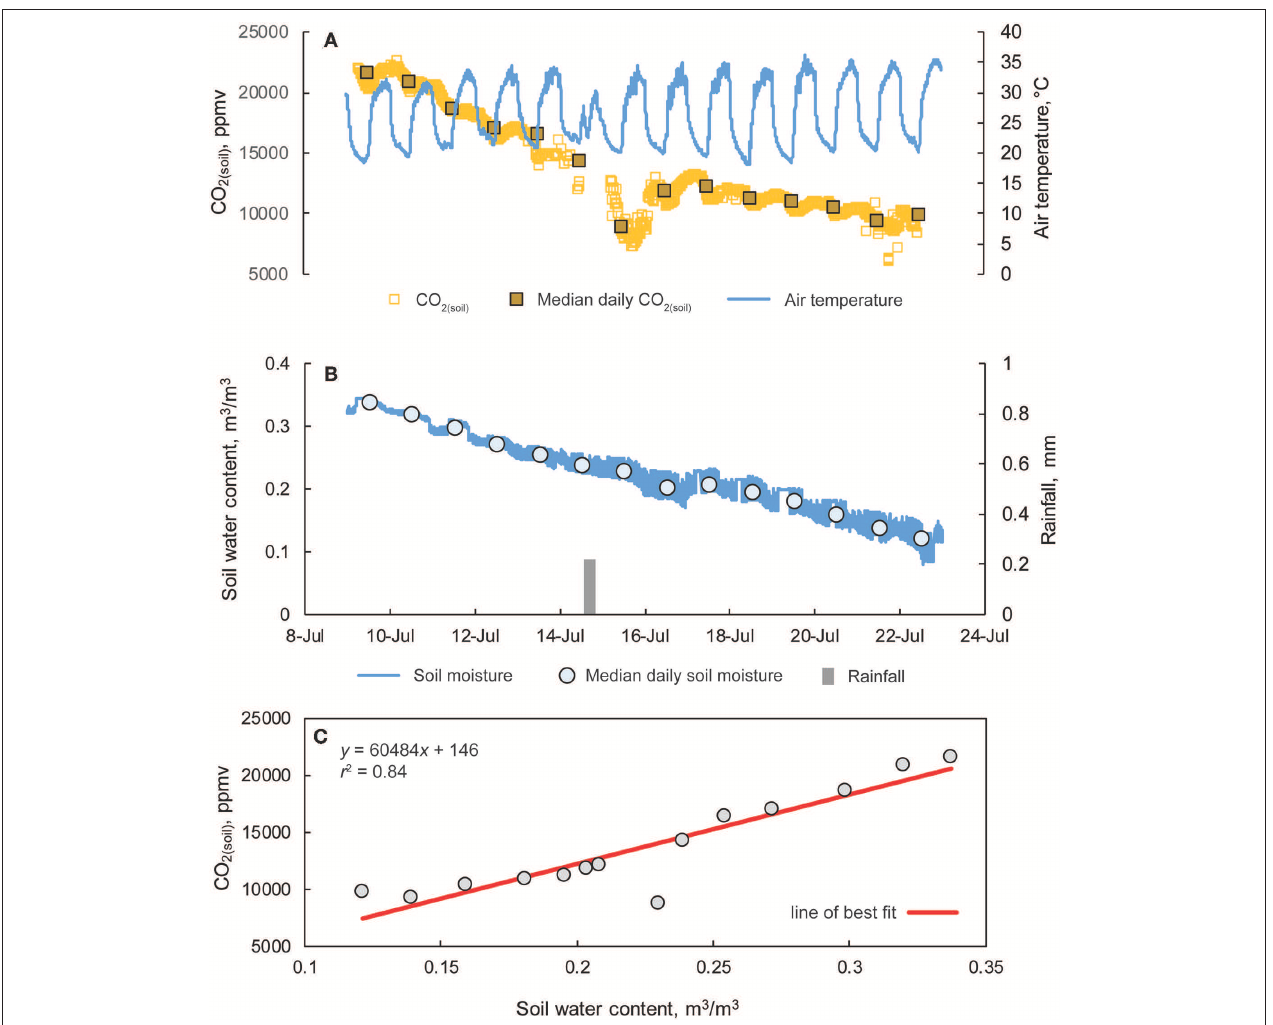
FIGURE 11 | (A) Hourly CO 2 (soil) concentrations and median daily values from a 10cm soil cavity and overlying air temperature from 9 to 24 July at the Savoy Experimental Watershed. (B) Fifteen-minute interval measurement of soil moisture, median daily soil moisture values, and rainfall totals measured from a weather station located ∼ 2m from the soil cavity. (C) CO 2(soil) vs. soil water